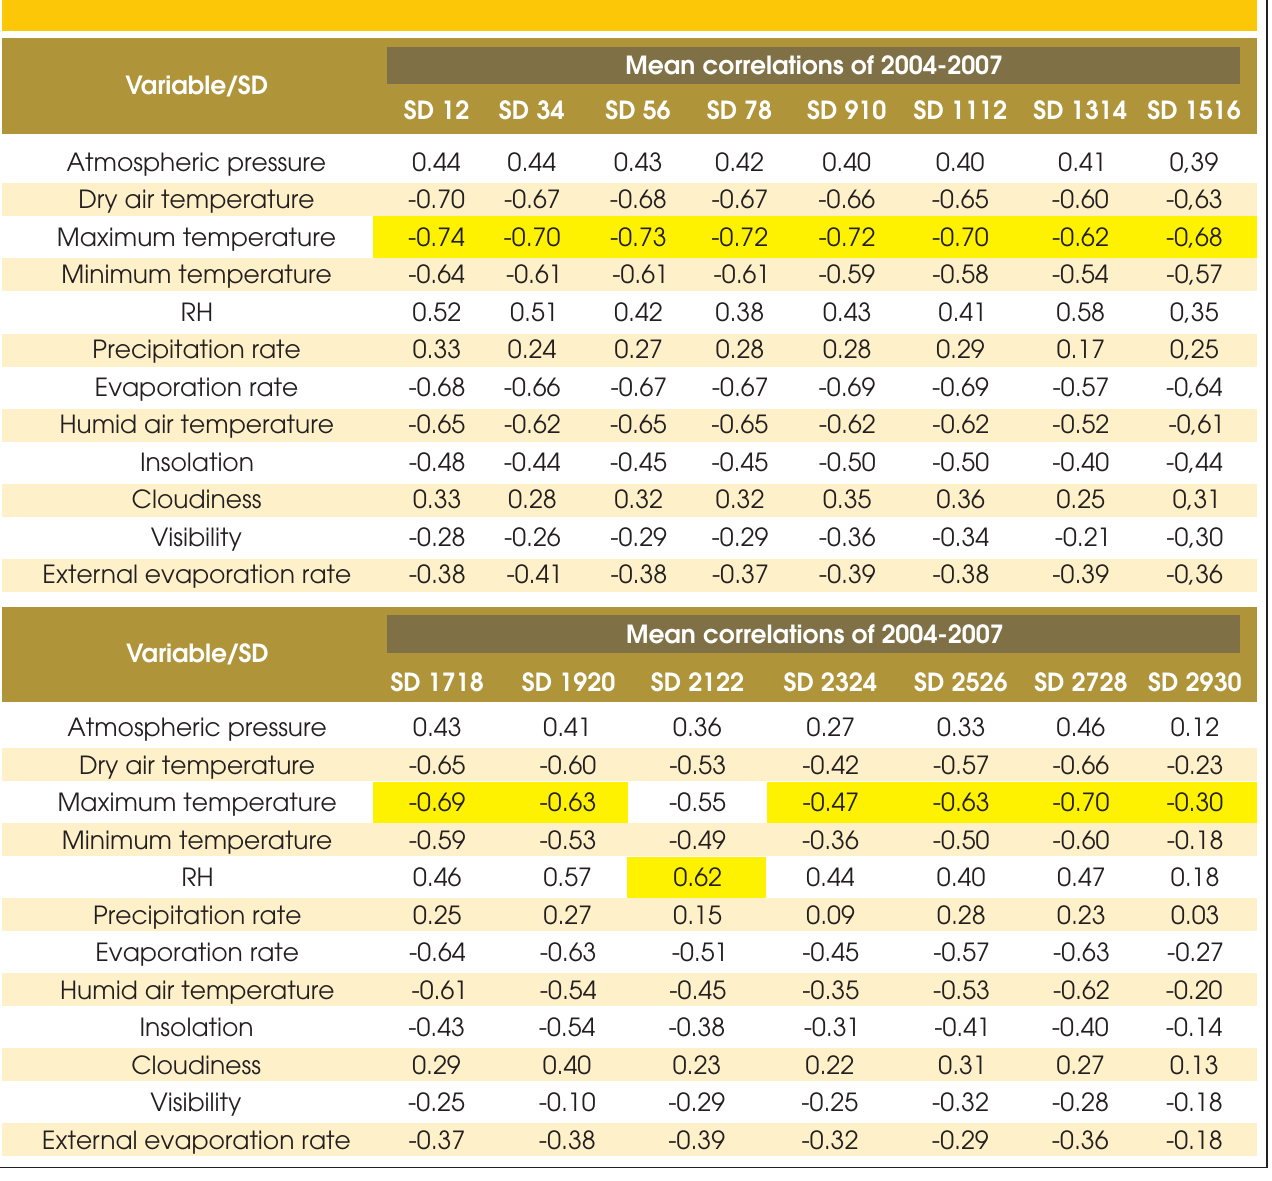
Table 6 – Correlations of concrete families with environmental